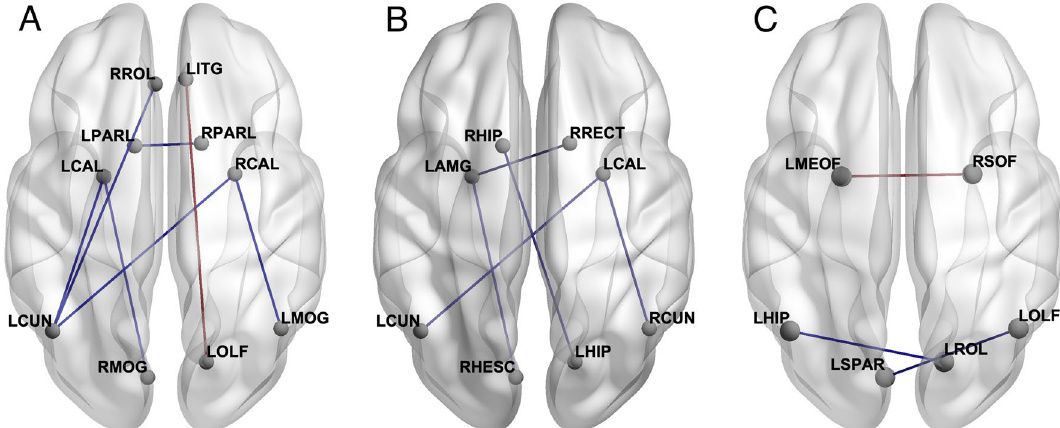
Figure 1. The chemotherapy group demonstrated significantly ( p < 0.05, FDR corrected) hypo-connected (blue lines) and hyper-connected (red lines) edges compared to the chemotherapy naïve group ( A ) and hypo-connected edges compared to healthy controls ( B ). The chemotherapy naïve group showed both hypo- connected (blue lines) and hyper-connected (red lines) edges compared to healthy control ( C ). LAMG left amygdala, LCAL left calcarine, LCUN left cuneus, LHIP left hippocampus, LITG left inferior temporal gyrus, LMEOF left medial orbital frontal, LMOG left middle occipital gyrus, LOLF left olfactory, LPARL left parietal lobule, LROL left rolandic operculum, LSPAR left superior parietal lobe, RCAL right calcarine, RCUN right cuneus, RHESC right Heschl’s gyrus, RHIP right hippocampus, RMOG right middle occipital gyrus, RPARL right parietal lobule, RRECT right rectus gyrus, RROL right rolandic operculum, RSOF right superior orbital frontal. Figure created using BrainNet Viewer 51